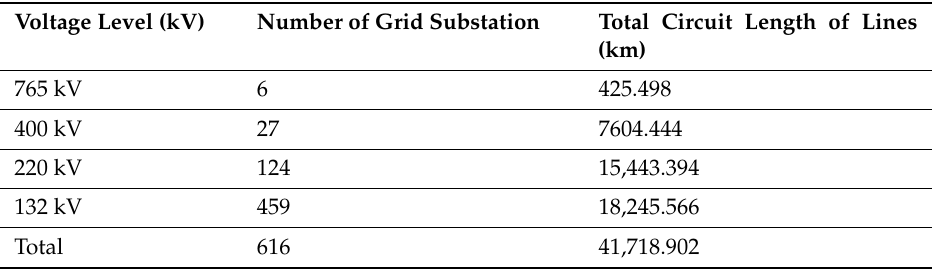
Table 5. Number of Grid Substations and Circuit Length of Transmission Lines in Rajasthan.